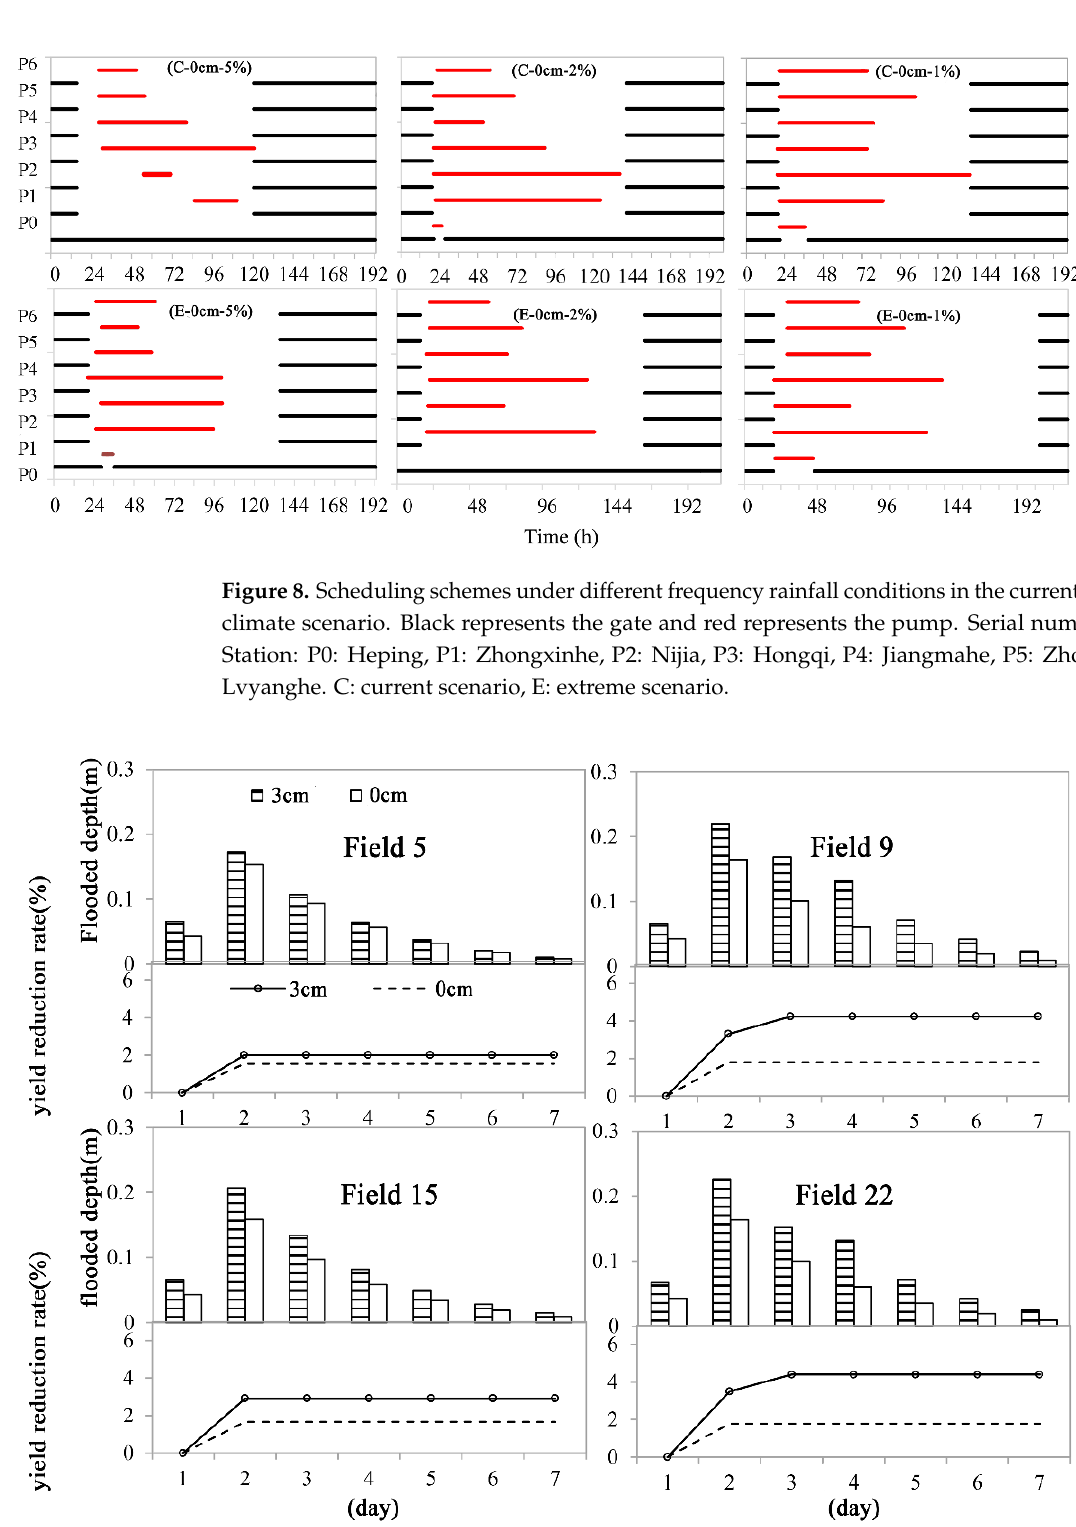
Table 3. Waterlogging loss of study area under different initial storage depths in the current condi- tion (unit: 10 3 yuan).